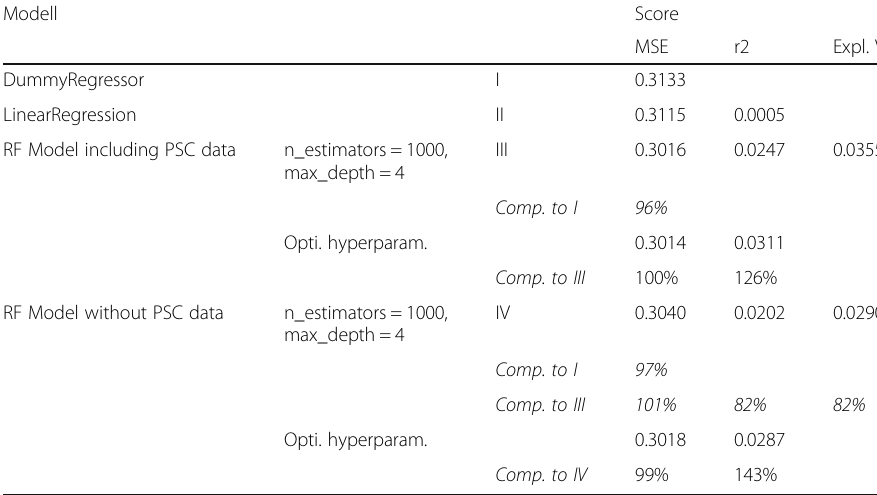
Table 2 Performance of the tested models